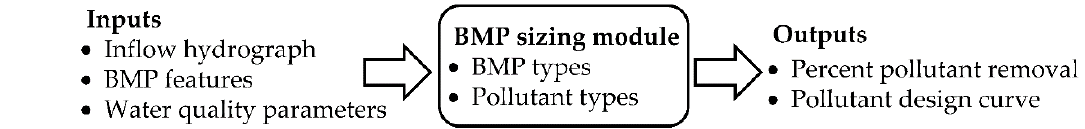
Figure 1. Conceptual framework for water quality module.